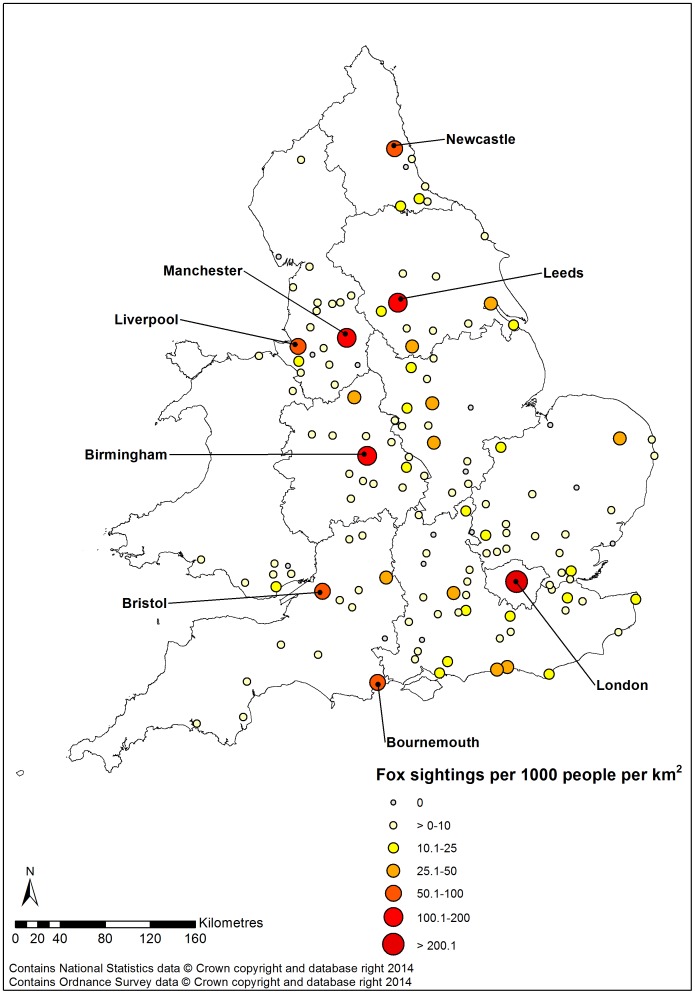
Density of fox sightings in Great Britain.Density of fox sightings based on publicity submitted sightings in the 144 cities used within statistical models. The size of circles depicts the number of fox sightings per 10002.